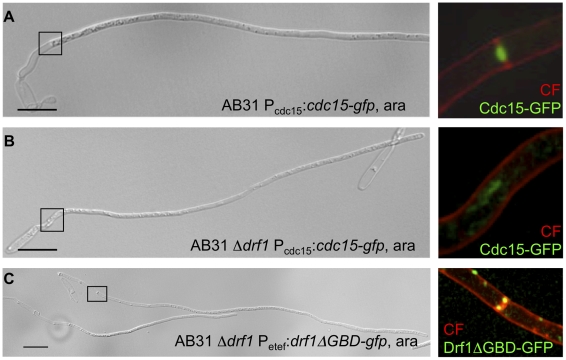
Hyphal septation depends on CAR formation.A: CAR formation in wt filaments is shown by the actomyosin ring marker Cdc15-GFP (green) and co-staining with calcofluor white (red). The magnification shows the formation of the first distal septum (red) while the actomyosin ring started to constrict (green). B: The same settings were used for the AB31Δdrf1 mutant expressing Cdc15-GFP. The region of the bud neck is magnified. C: The constitutive active variant Drf1ΔGBD-GFP (green) was expressed in AB31Δdrf1 and localized in filaments at the site of restored hyphal septation (red). (Scale bars: 15 µm).